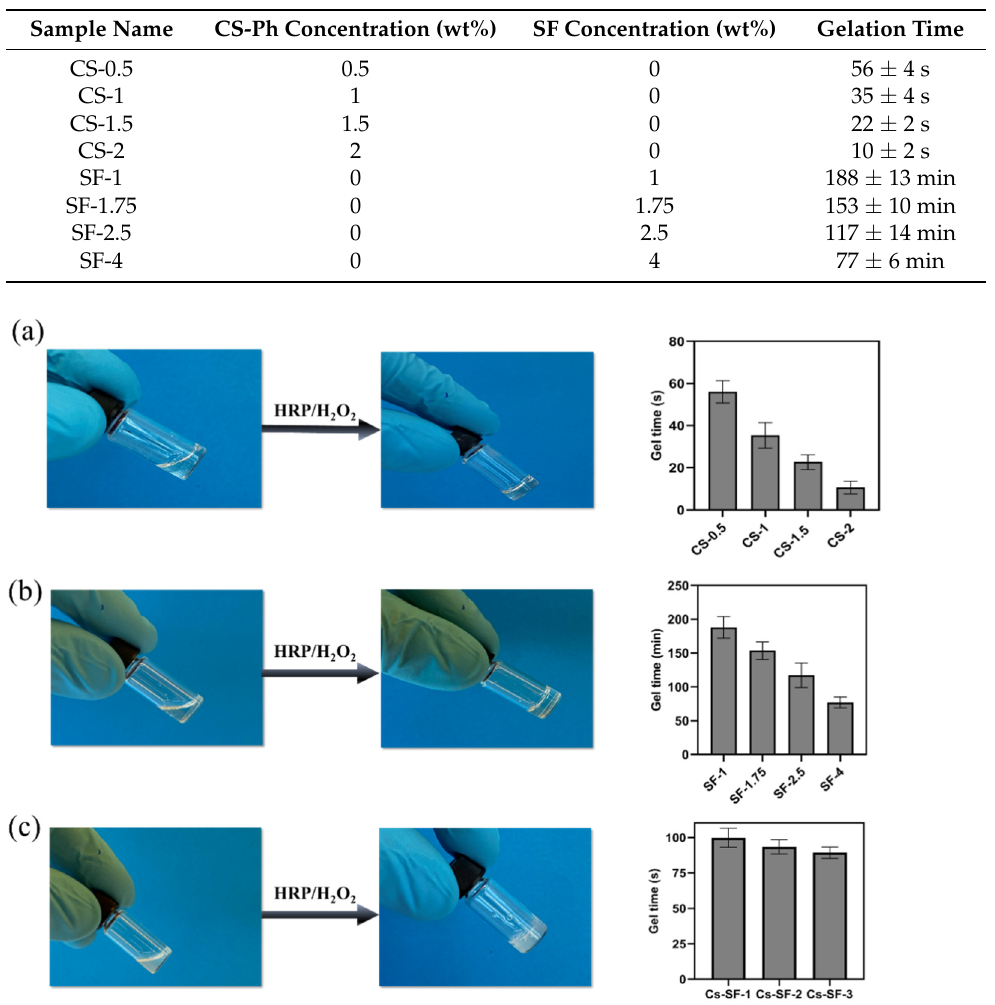
Table 1. Parameters and gelation time of chitosan (Cs) and silk (SF) hydrogels.